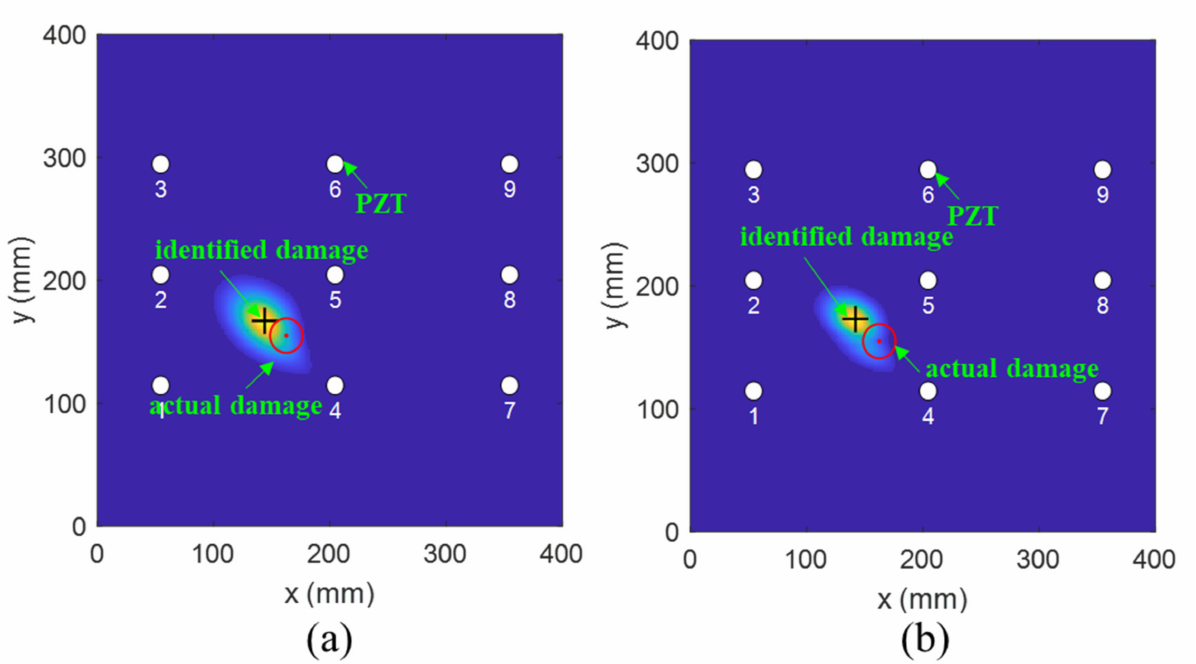
Figure 15. The imaging results of one virtual damage at location (150 mm, 230 mm) obtained by ( a ) the fused PDI method and ( b ) the conventional PDI method.